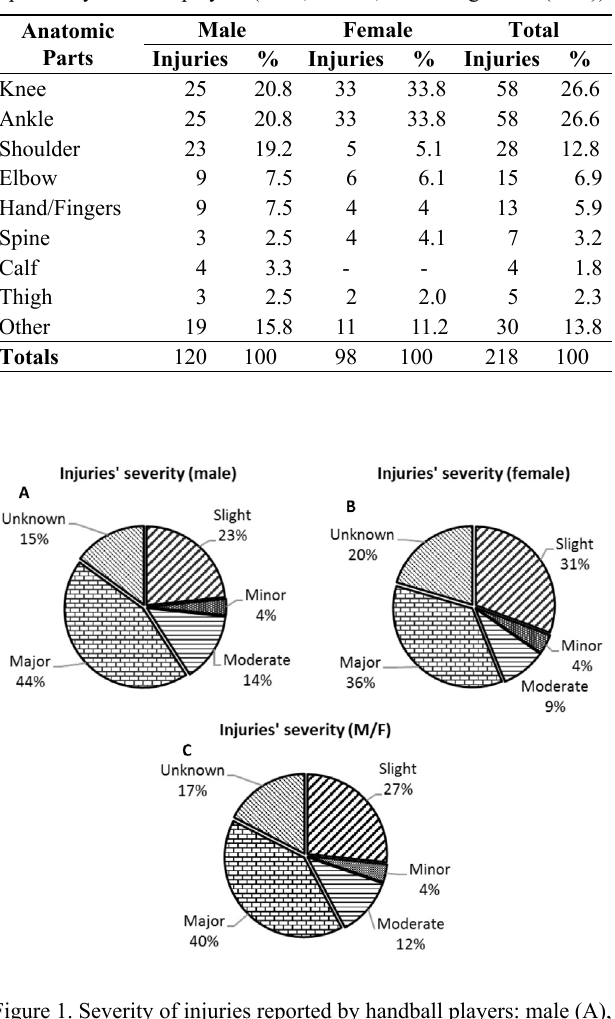
Table 2. Absolute and percent values of injuries by anatomic part reported by handball players (male, female, and both genders (total)).